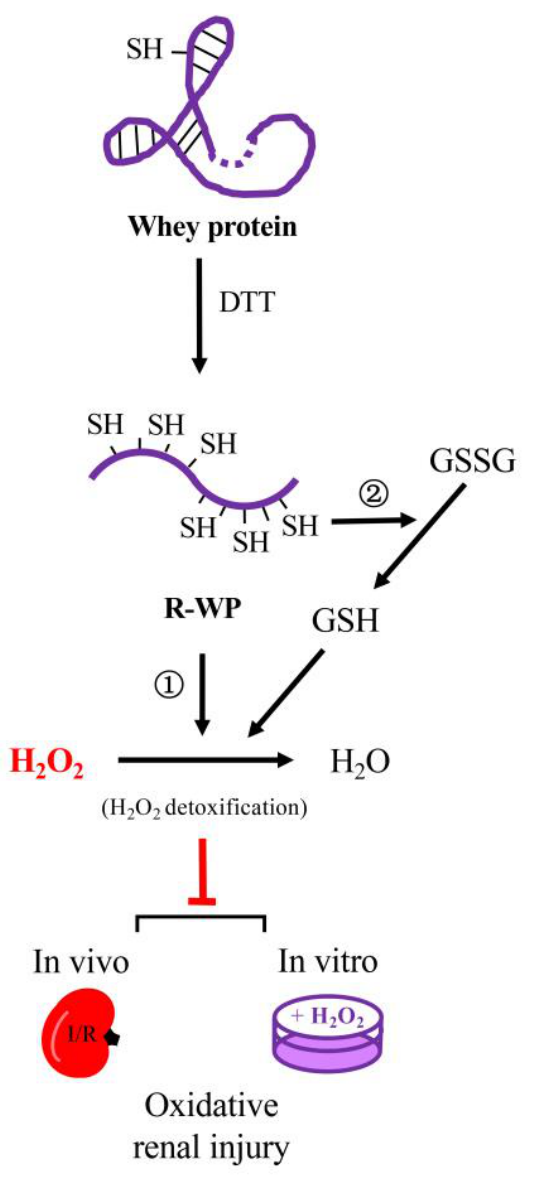
Figure 8. Schematic depiction of the mechanisms involved in the antioxidative actions of the reduc- tively modified whey protein. Reductive modification of WP with DTT results in the release of -SH groups via splitting of disulfide bonds in protein structure. The exposed -SH groups exert antioxi- dative actions through ① direct detoxification of H 2 O 2 , and ② integration to thiol antioxidative sys- tem, consequently, leading to prevention of H 2 O 2 -induced oxidative cell injuries in both in vitro and in vivo systems. The WP depicted in the cartoon is a representative of WP components that possess disulfide bonds in their structure, such as albumin.